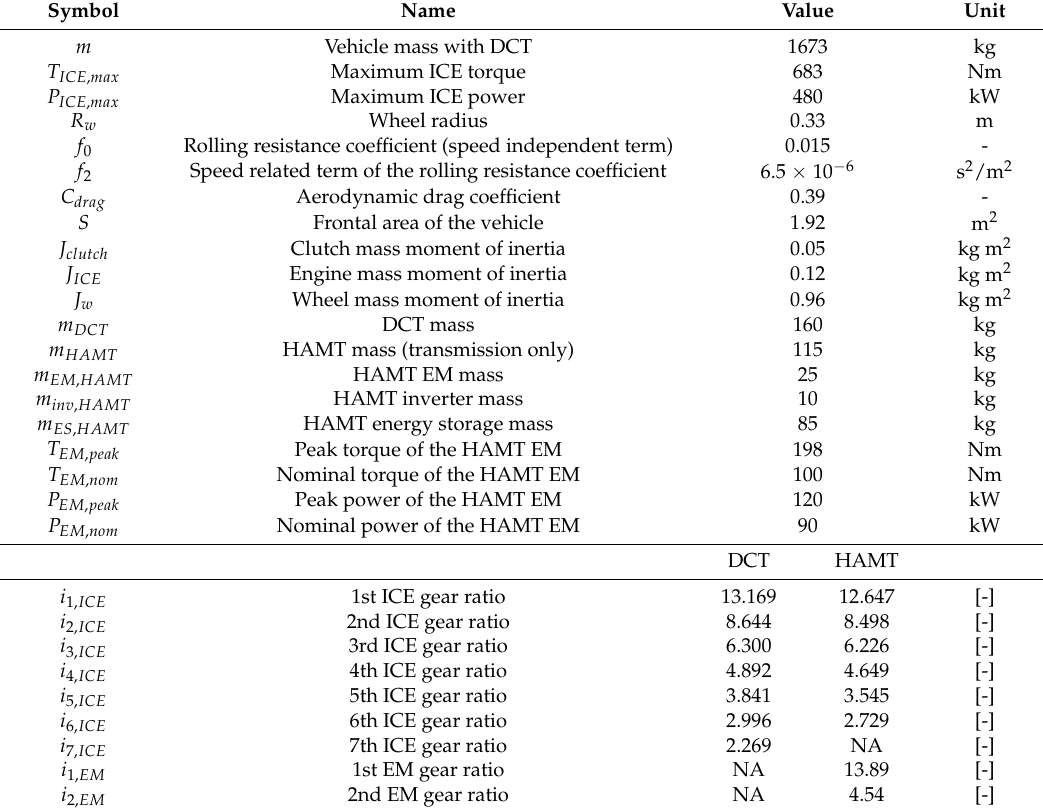
Table 1. Main vehicle and transmission